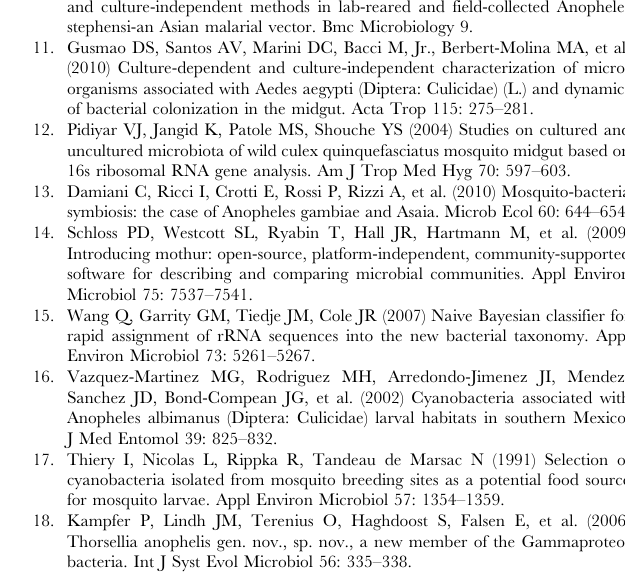
Table S3 Gut bacterial composition at family level across life stages of An.gambiae . Table S4 Gut bacterial composition at genus level across life stages of An.gambiae . Table S5 Differentially abundant families between pupal and newly emerged adult guts. Table S6 Differentially abundant families before and after a blood meal. Table S7 Differentially abundant genera before and after a blood meal. Table S8 Genomic comparison on anti-stress subsys- tems in abundant bacteria species from blood fed and sugar fed guts. Table S9 Comparison of gut bacterial composition at family level between Kenyan and lab